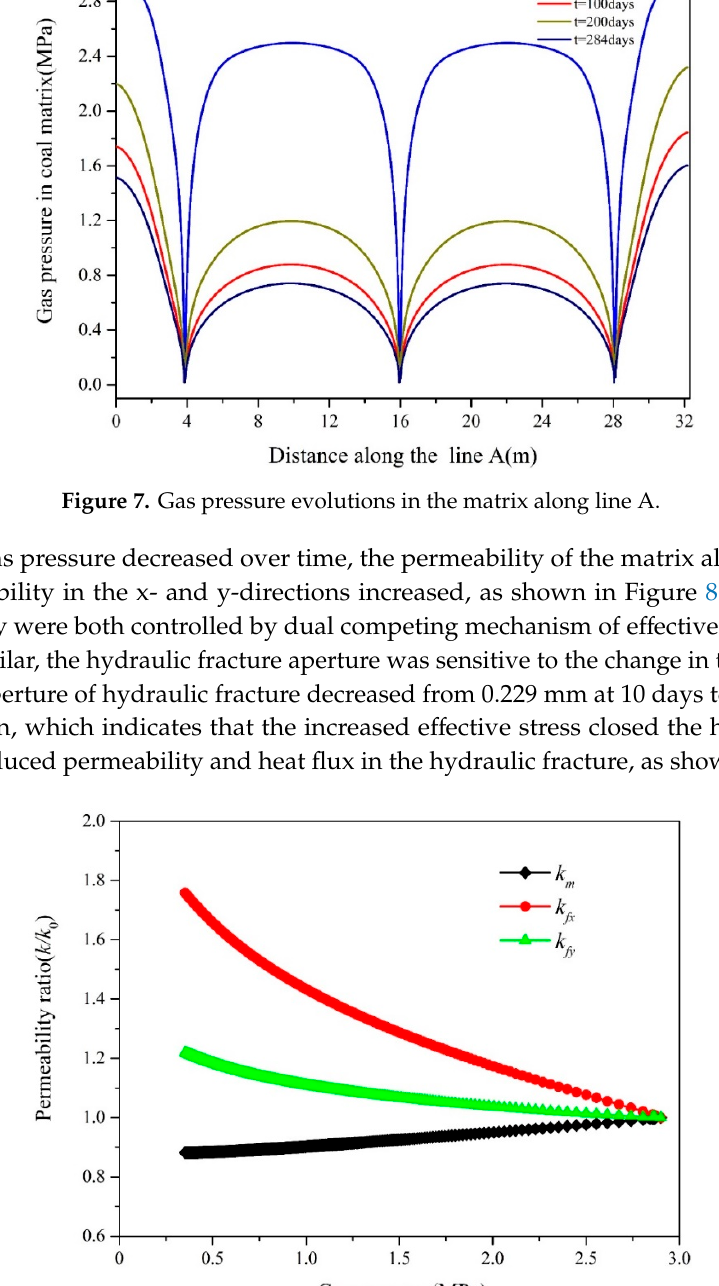
Figure 6. Gas pressure distribution of the matrix at different times.